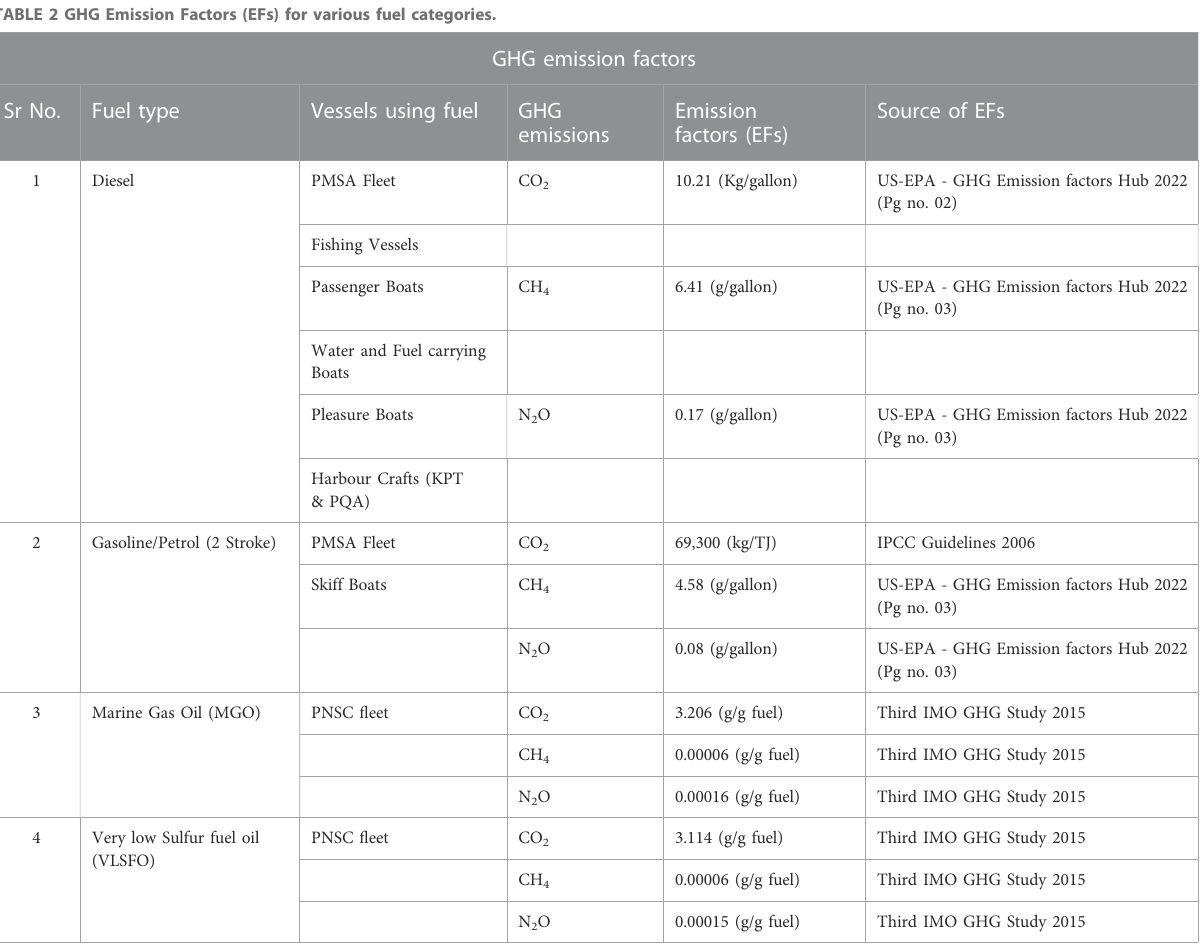
TABLE 2 GHG Emission Factors (EFs) for various fuel categories.